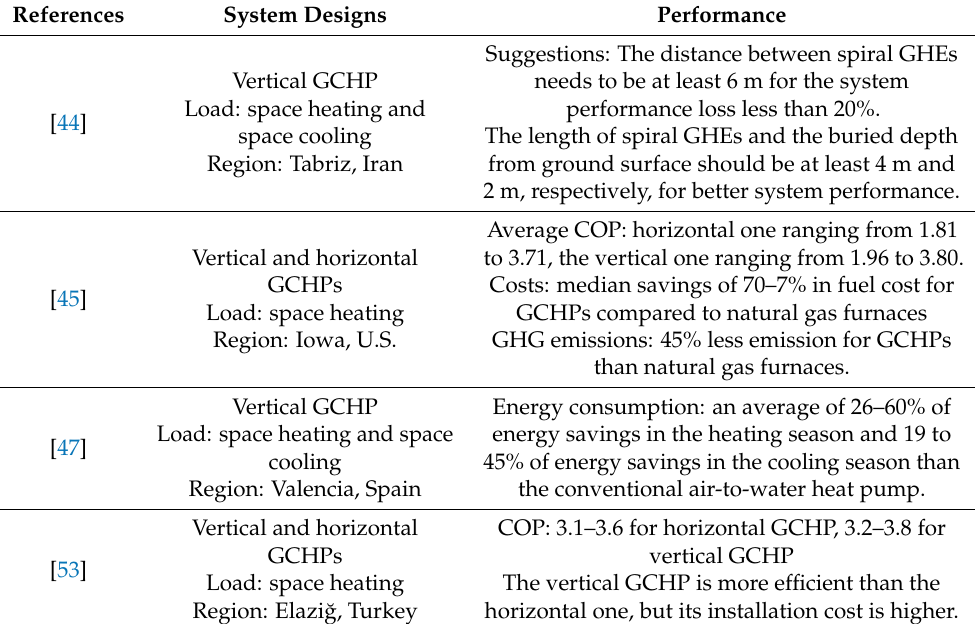
Table 3. Summary of studies of GSHP